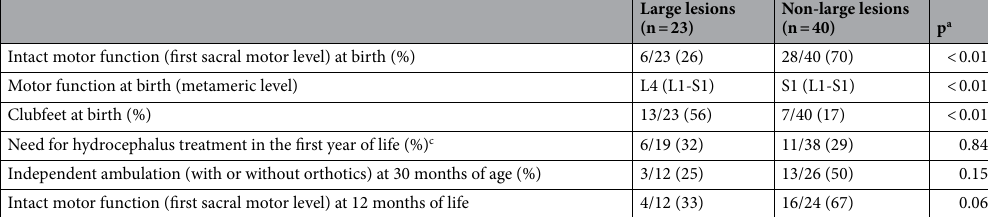
Table 1. Comparison of neurological, neurosurgical and neonatal characteristics between large and non-large myelomeningocele in the entire cohort. Large lesion was defined when volume was > 2.7 cc. L2, second lumbar vertebrae; CSF, cerebrospinal fluid; a Represents the comparisons between the large and non-large lesion group. Quantitative data were expressed as mean ± standard deviation if normal distribution or median (range) if non- normal distribution (as detected by Kolmogorov–Smirnov). Quantitative variables were compared using t-test for independent samples if there was a normal distribution. If a non-normal distribution was present non- parametric tests were used (Mann–Whitney U test). Qualitative variables were compared using Chi-square or Fisher’s exact test. A p-value < 0.05 was considered significant. b Grade 0 (normal); grade 1 (visible fourth ventricle and cisterna magna without cerebellar displacement below the foramen magnum, tentorium could be vertically oriented, and tectal beaking could be present); grade 2 (visible cisterna magna without displacement of cerebellum below the foramen magnum, no visible fourth ventricle); grade 3 (cerebellar ectopia below the foramen magnum and obliteration of all posterior fossa CSF spaces). c Hydrocephalus treatment: including ETV and/or ventriculoperitoneal shunt.